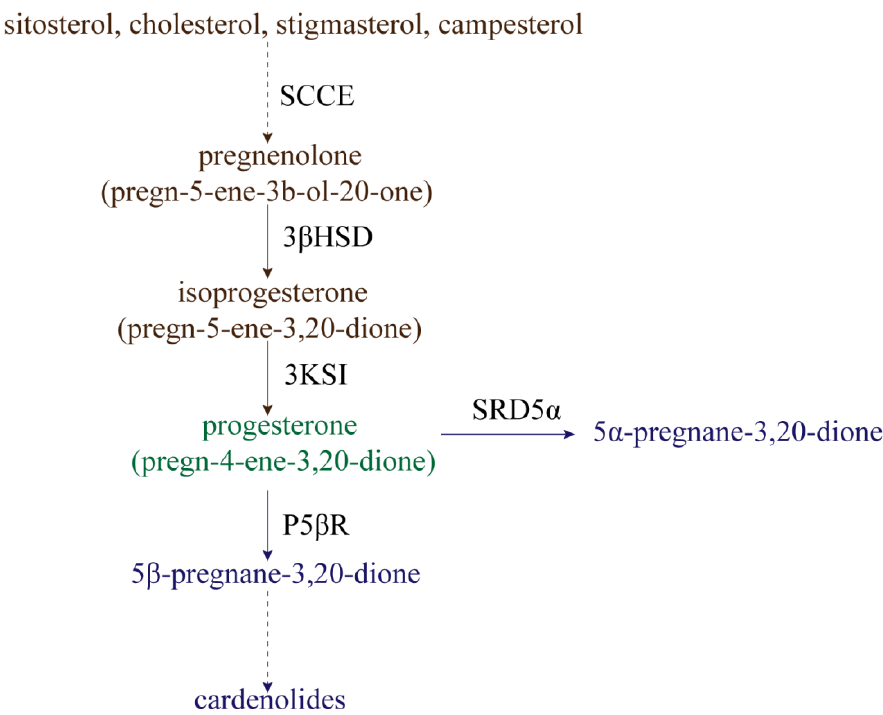
Figure 1. The synthesis and reduction processes of progesterone in plants. SCCE: side-chain-cleaving enzymes; 3 β HSD: ∆ 5 -3 β -hydroxysteroid dehydrogenase; 3KSI: ∆ 5 - ∆ 4 -ketosteroid isomerase; P5BR: progesterone 5 β -reductase; SRD5 α : progesterone 5 α -reductase.